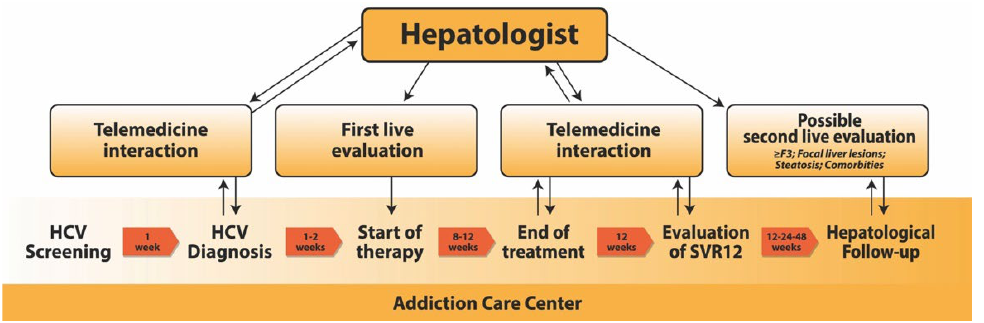
Figure 2. Graphic description of our “patient–centered approach” to HCV treatment in PWUDs.